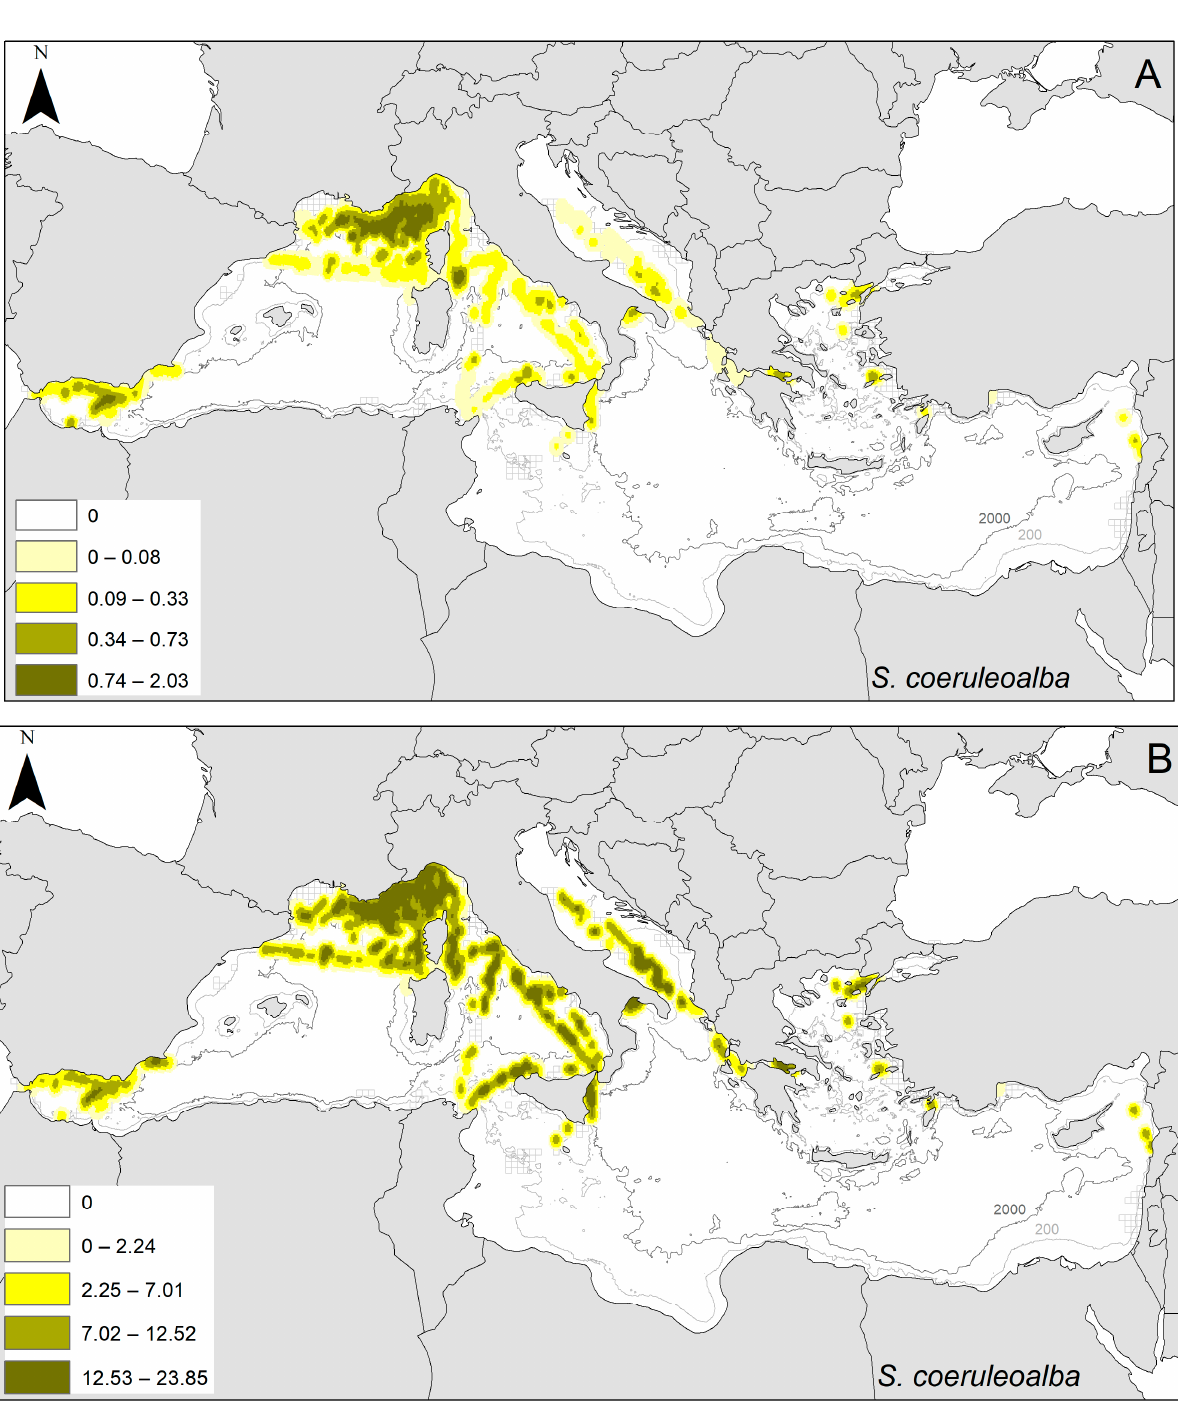
Figure 6. The encounter rate map ( A ) and the prevalence map ( B ) of the striped dolphin ( Stenella coeruleoalba ), processed through Kernel density analysis. The striped dolphin was sighted in all areas of sampling, with a clear preference for the waters outside the continental shelf (>200 m), even very close to the coastline and in semi-closed contexts, provided there was the right water depth (such as in the Gulf of Corinth, Greece). Its ER is higher in the western basin, specifically in the Alboran Sea and in the north-western Mediterranean. The striped dolphin shows a high prevalence in most of the sampled offshore waters ( B ), confirming its status as a dominant species of the offshore domains. However, in the Alboran Sea, its prevalence is relatively low (despite the high ER), probably due to the coexistence of other species (Kernel density parameters: cell size x, y = 5 × 5 km; radius ≈ 30 km; criterion for division into classes: natural breaks).